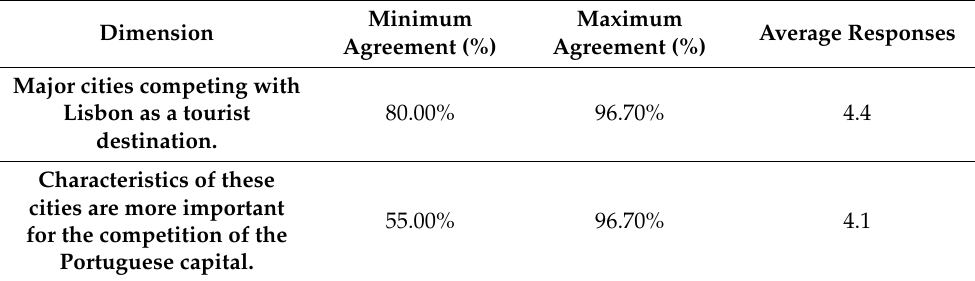
Table 15. Maximum and minimum agreement of the second domain of the interviews. Source: Elaborated by the